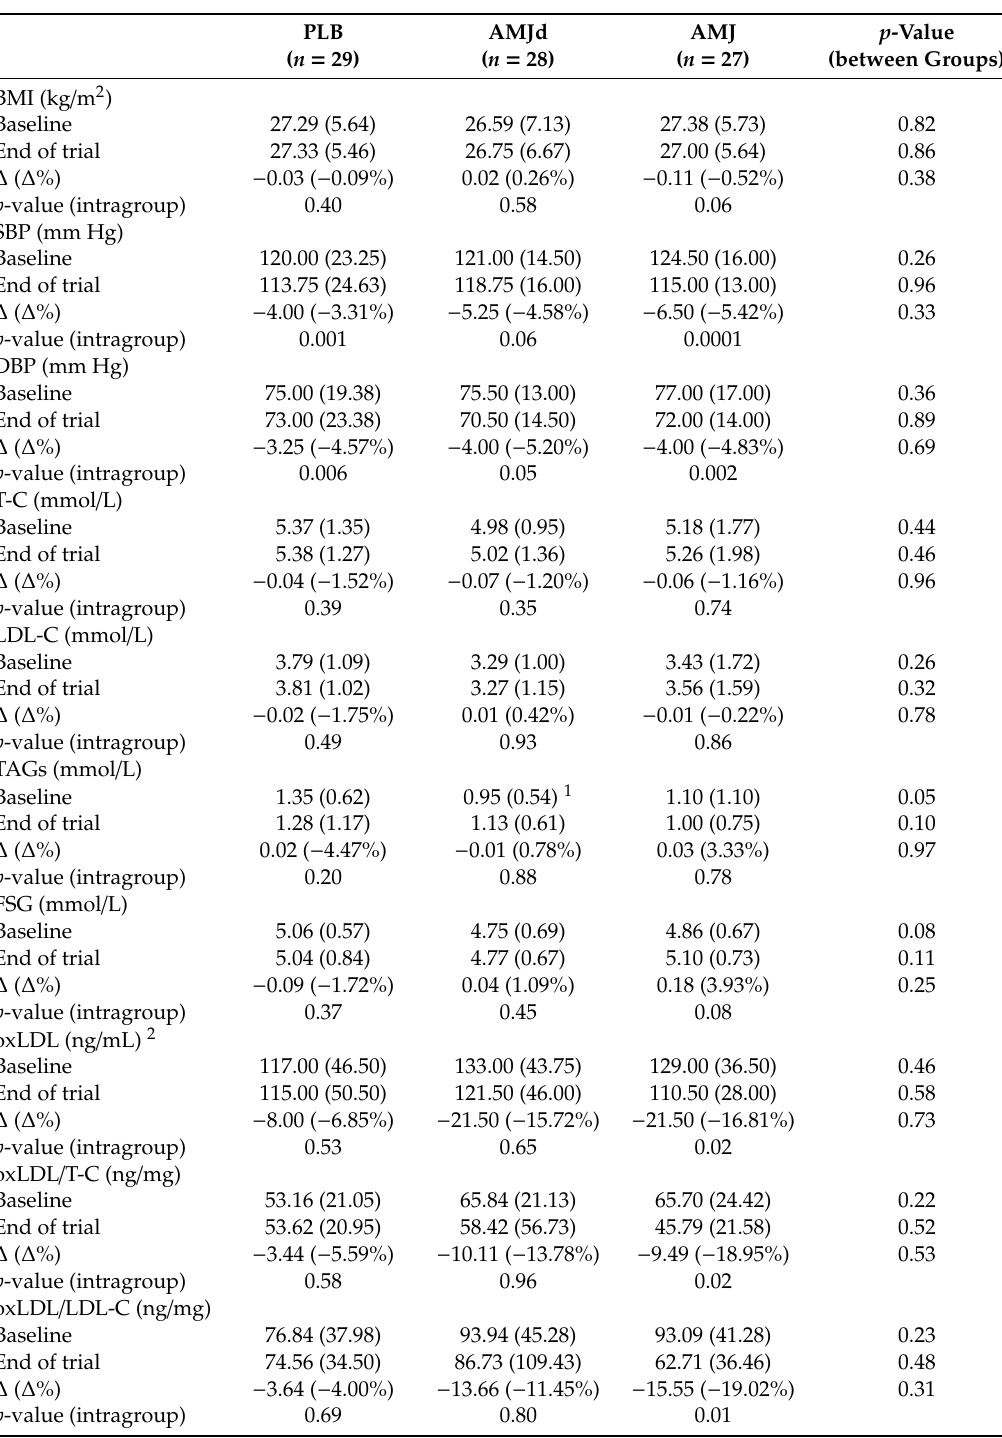
Table 1. Changes in some of the anthropometric and biochemical variables examined in this study following daily intervention for four weeks with the placebo (PLB) drink, the polyphenol